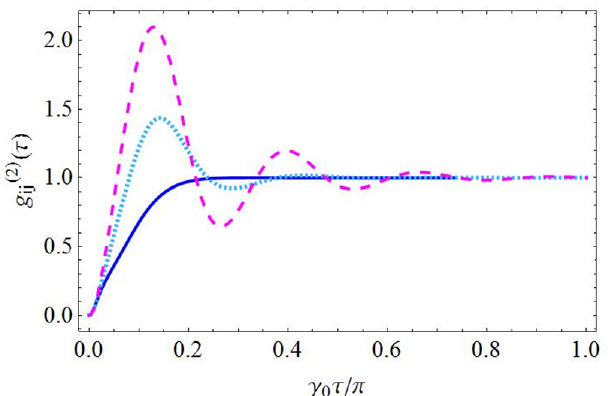
d = 27 nm (turquoise dotted curve) and d = 50 nm (magenta dashed curve), the Rabi oscillations are not washed out, since the corresponding decay rates (3.50 γ 0 and 1.82 γ 0 ) are 2 γΩ = and 0 ω = Δ = . Blue solid Figure 9. The second-order correlation functions, for comparable to value of the Rabi frequency. We observe that the period of the oscillations 0 21 = = detected on the second-order correlation function is importantly increased as compared curve: 10 nm d , turquoise dotted curve: 27 nm d and magenta dashed curve: to the strong field regime explored in Figure 7, due to the substantial decrease of the Rabi 50 nm d = . frequency, while the crossing time increases monotonically with the interparticle distance ( τ = 0.080 π / γ 0 , for d = 27 nm and τ = 0.056 π / γ 0 , for d = 50 nm).